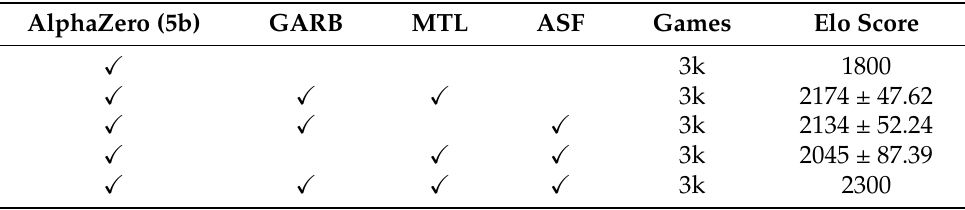
Table 2. Comparison of Elo ratings among original AlphaZero, AlphaZero with only network curriculum learning, AlphaZero using some of the techniques in this paper, and complete NoGoZero+. ASF, advanced specific features; MTL, multitask learning network structure; 5b, number of residual blocks in the network.